Question: Sum up the contents of this chart in one sentence.
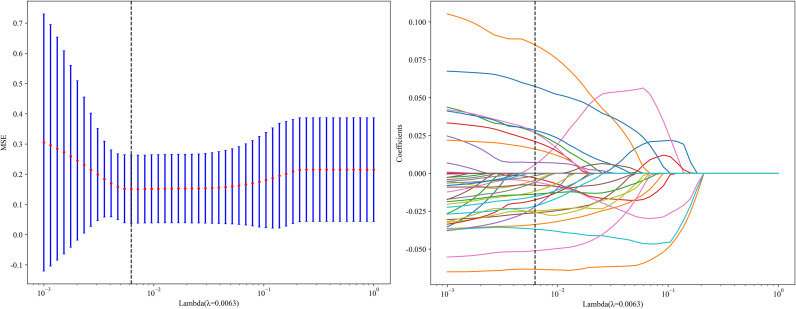
Answer: Hand-crafted radiomics feature selection using the least absolute shrinkage and selection operator (LASSO) and the histogram of radiomics feature importance scores based on the selected features. The optimal λ value of 0.0063 was selected.